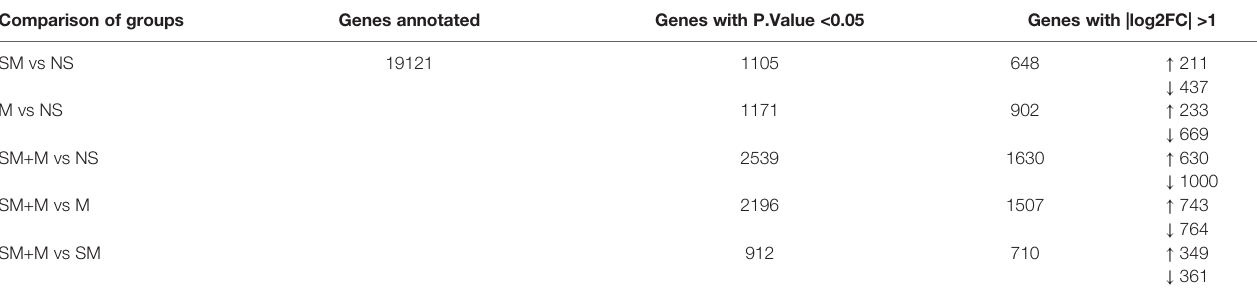
Comparison of groups Genes annotated Genes with P.Value